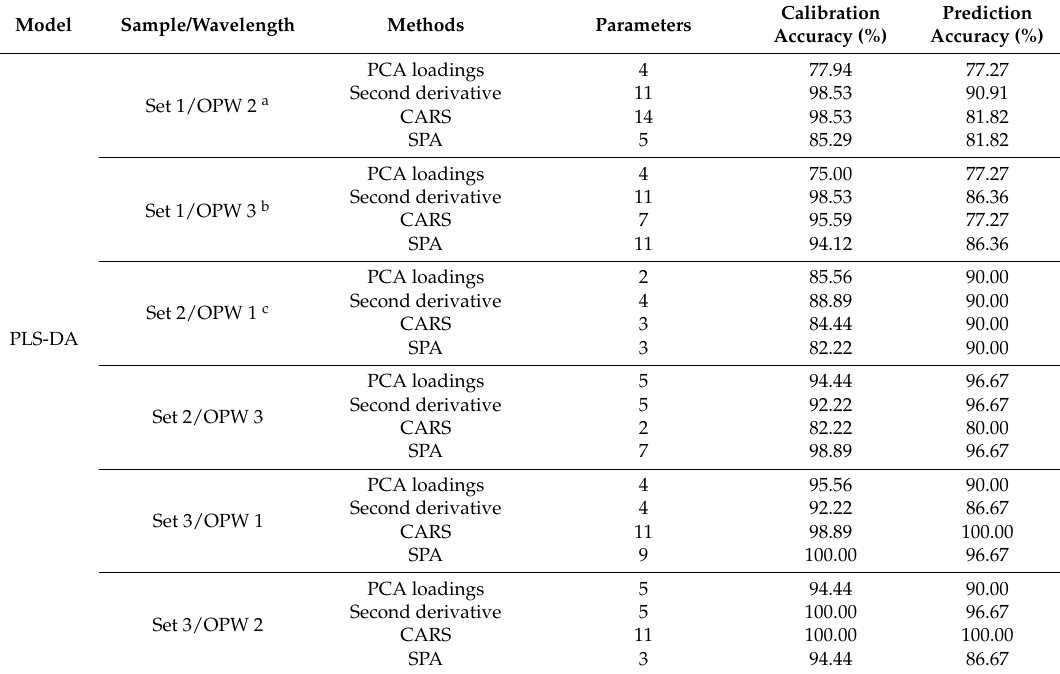
Table 4. The discriminant results of the sample sets using the optimal wavelengths selected by the other sample